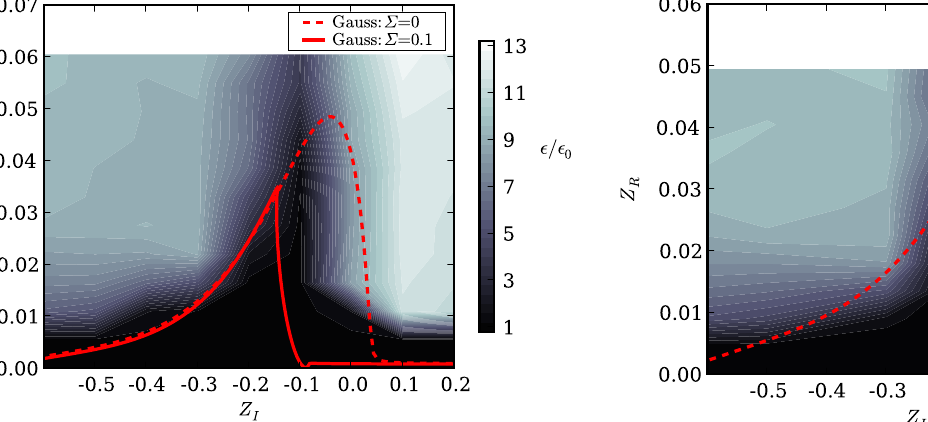
FIG. 9. (Color) Simulation scan of the stability boundary in the normalized impedance plane for a single rf wave and (cid:1) (cid:7) 0 : 5 . The bunch length of the initially matched Gaussian distribution (cid:7) 60 (cid:12) . The dashed red curve represents the stability is (cid:1) m boundary obtained from the dispersion relation equation (28) for (cid:1) (cid:7) 0